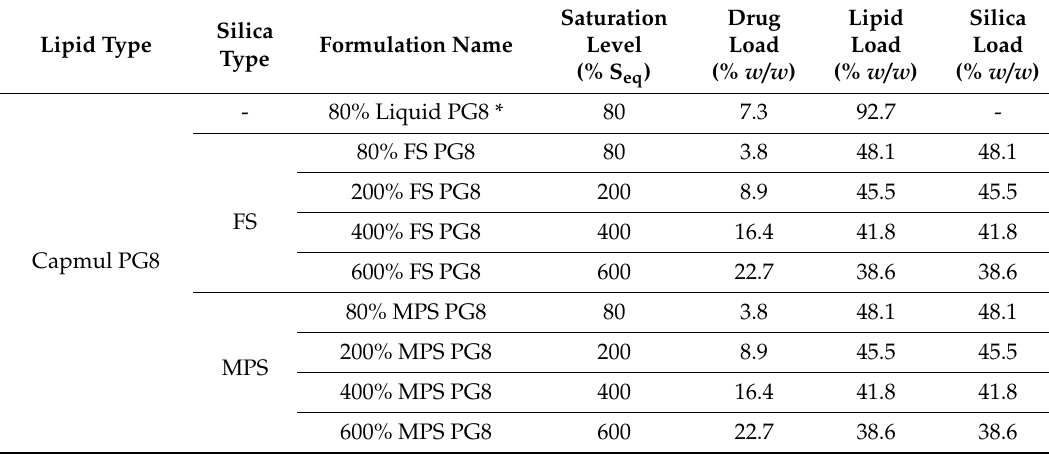
Table 1. The calculated composition of the fabricated FEN-loaded liquid and silica-lipid hybrid (SLH) formulations.